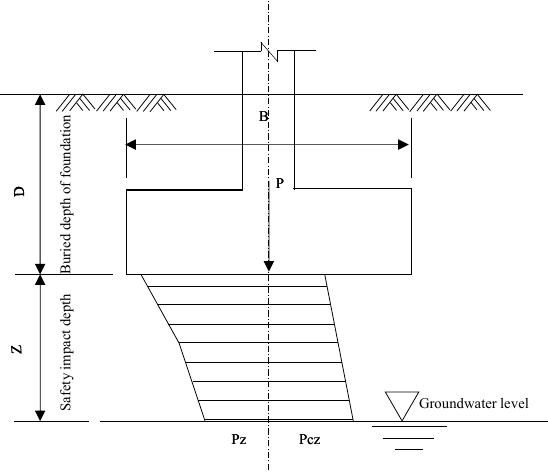
Figure 4. Safe depth for the impact of groundwater level rise.